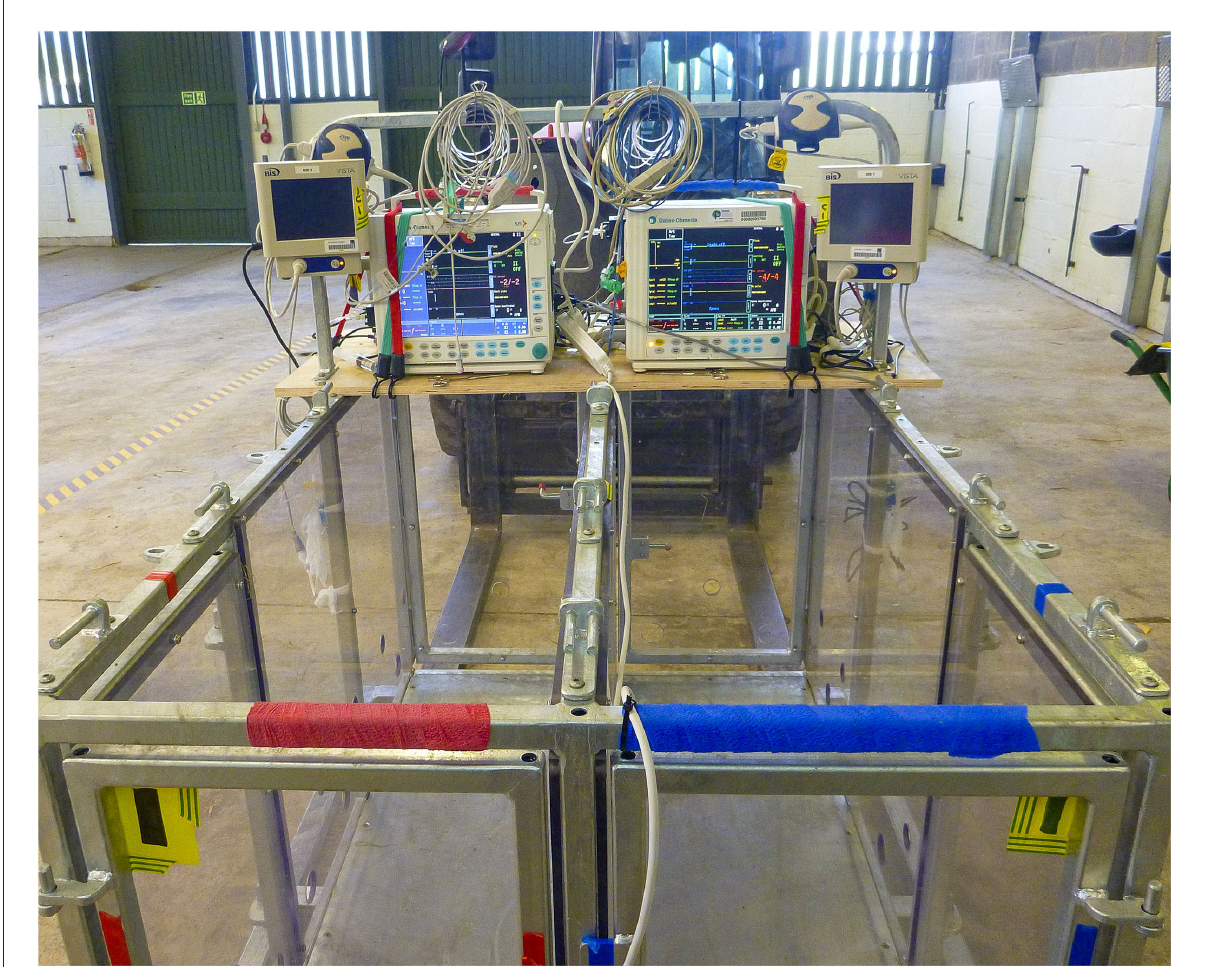
FIGURE1 Custom-built holding crate consisting of a galvanized steel frame with clear polycarbonate sides and doors with top tray housing physiological monitors. The crate allowed pairs of pigs to be safely housed in slings in individual compartments during terminal treatments with an unobstructed 360 ◦ view of the animals from the CCTV cameras. The base frame of the crate was manufactured to allow maneuverability via forklift